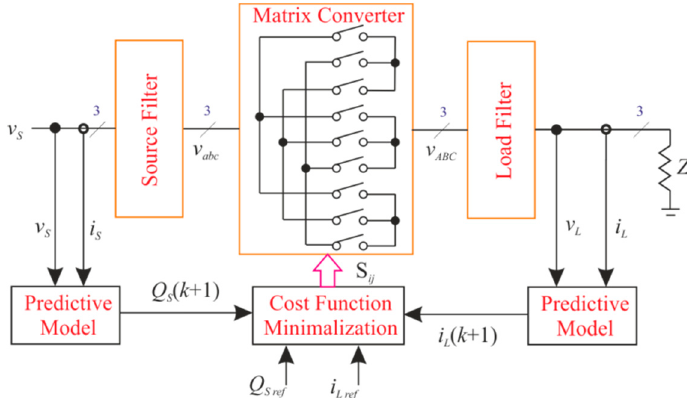
Figure 16. Model predictive control (MPC) of an MC with minimalization of the output current ripples and input power factor (reactive power).